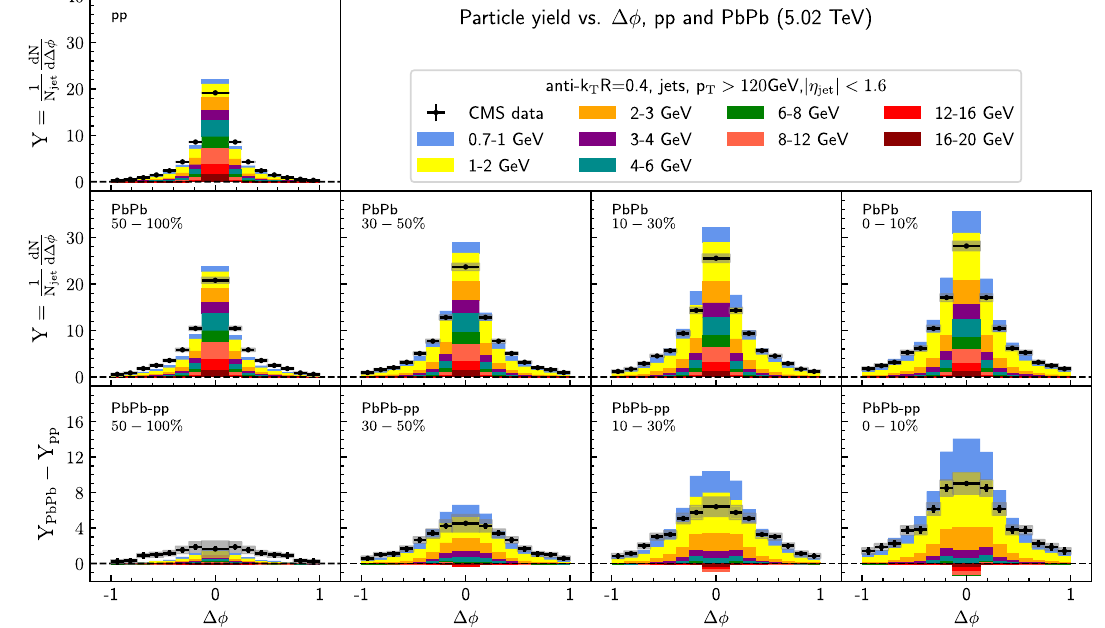
Fig. 5 Jet-correlated charged particle yield distribution as a function histograms are obtained from the AMPT model: different colors repre- of (cid:2)φ in p + p (top left panel), Pb + Pb (middle panels) collisions and sent the contributions from different p T intervals for charged particles. their differences (lower panels). Four different Pb + Pb collision cen- The accumulated histogram for 0 . 7 < p T < 20 GeV is compared to tralities are shown: 0 − 10% , 10 − 30% , 30 − 50%, and 50 − 100%. Jets CMS data > 120 GeV, R = 0 . 4 and | η | < 1 . 6. The stacked are taken with p jet jet T